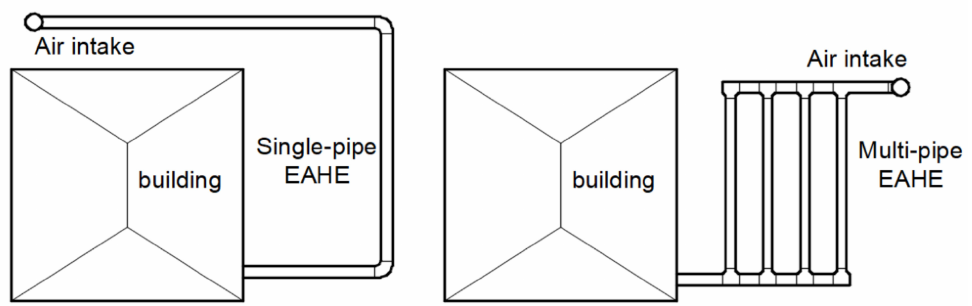
Figure 13. Schema of single-pipe and multi-pipe EAHE [72].